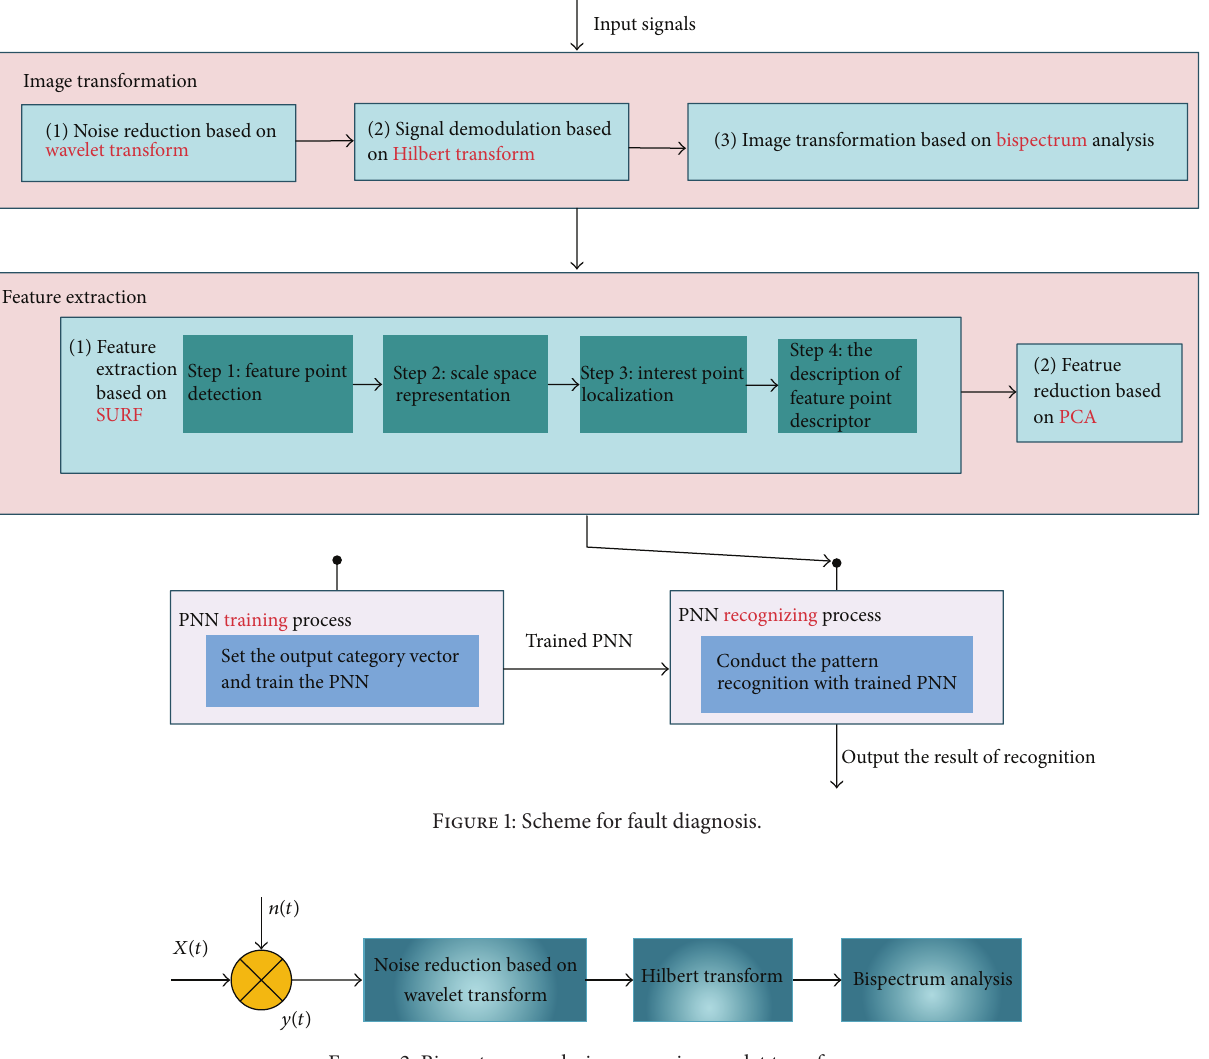
Figure 2: Bispectrum analysis process in wavelet